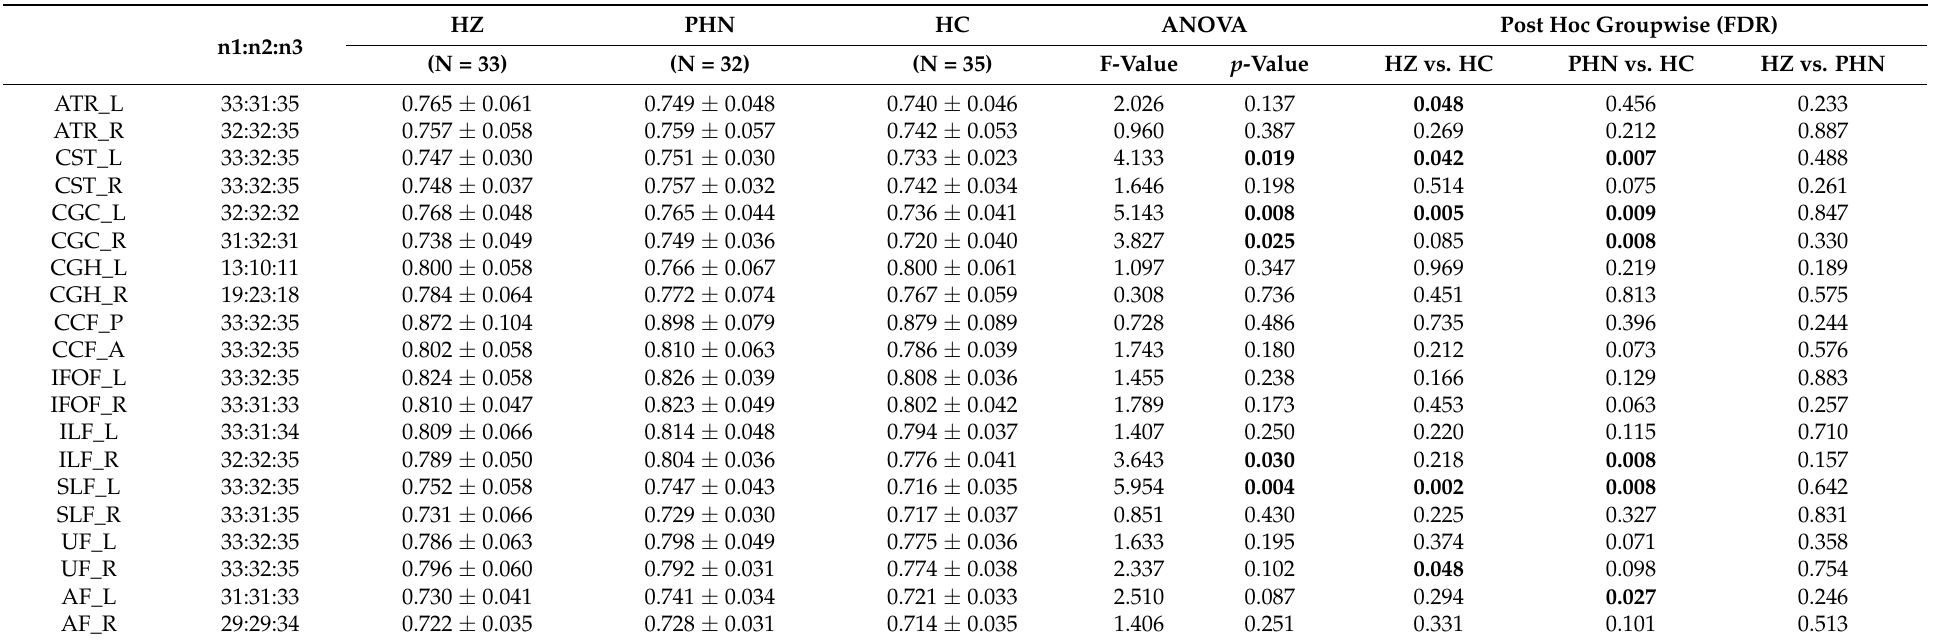
Table 3. Comparison of the mean MD among the three